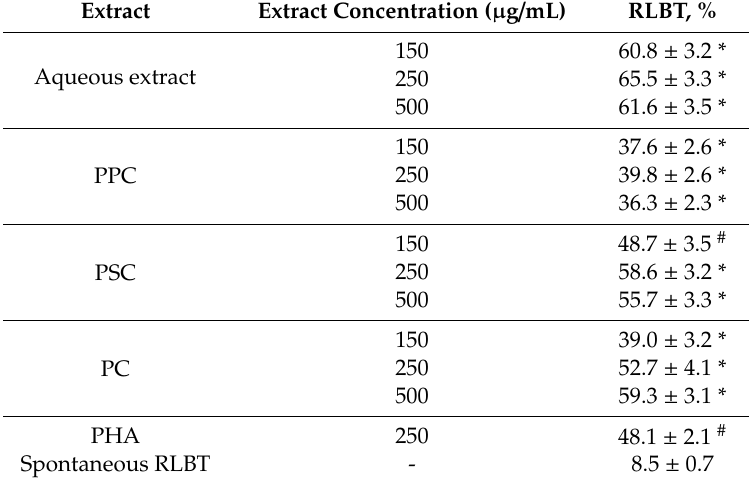
Table 3. The e ff ect of aqueous extract and other substances from G. aparine on the indices of lymphocyte blast transformation (X ± m), n =